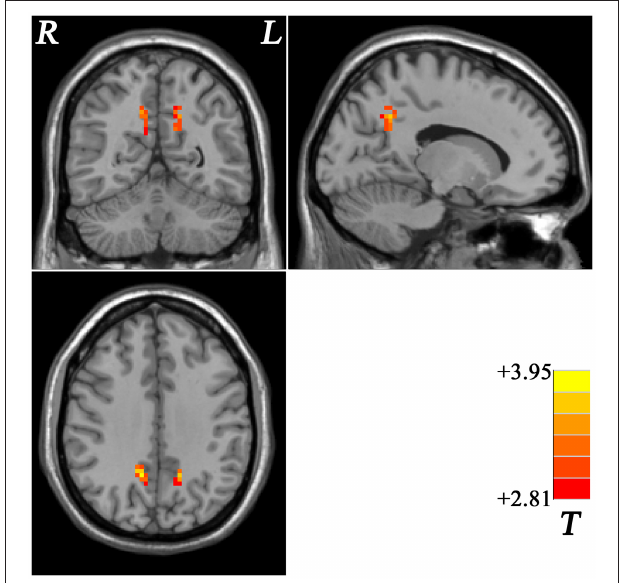
FIGURE 2 | Statistical map depicts higher ReHo in GI group compared with non-GI group. The threshold was FDR (false discovery rate) corrected at p < 0.05. Red denotes higher ReHo in the GI group. Th color bar indicates T values from post-hoc t -tests. L, lest side; R, right side; GI, gastrointestinal, ReHo, regional